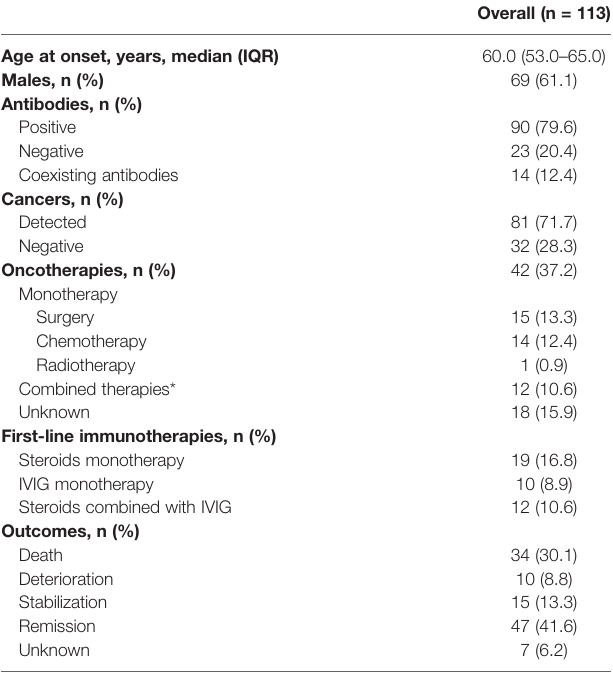
TABLE 1 | Summary of patients with PNSs.